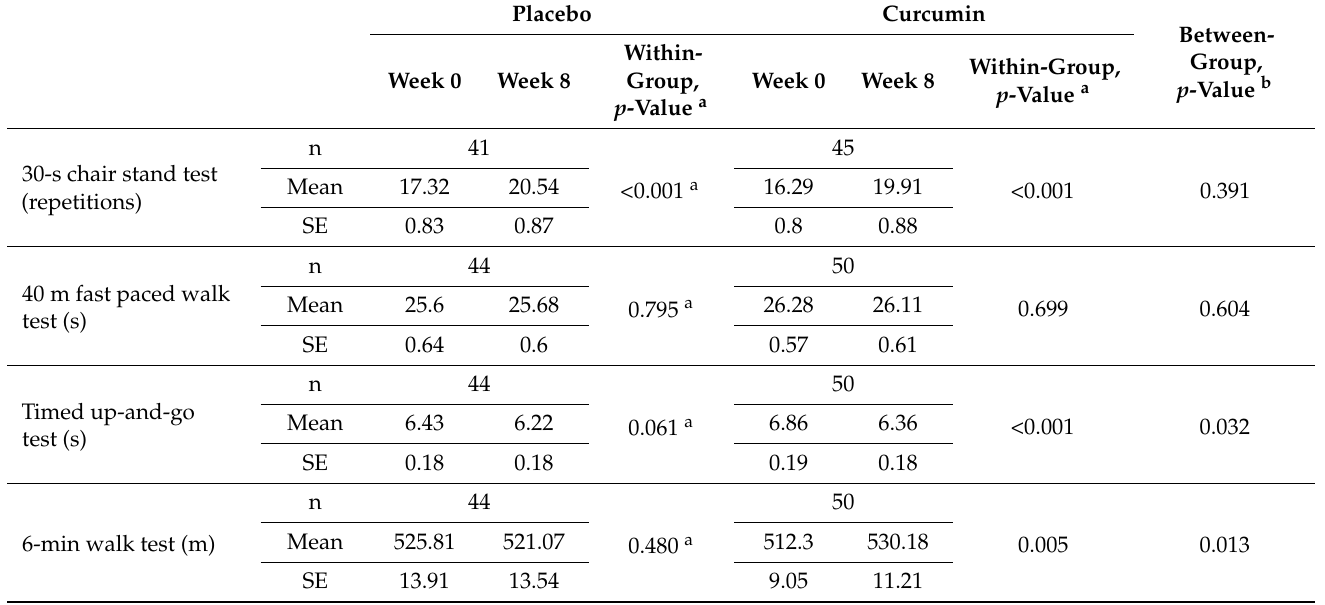
Table 4. Change in Performance-based Test